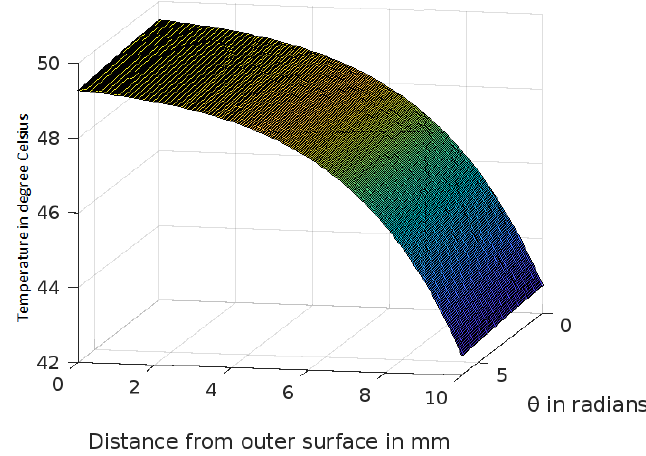
Figure 9. Variation of temperature profiles in human skin with an external temperature at the skin surface of 50 ◦